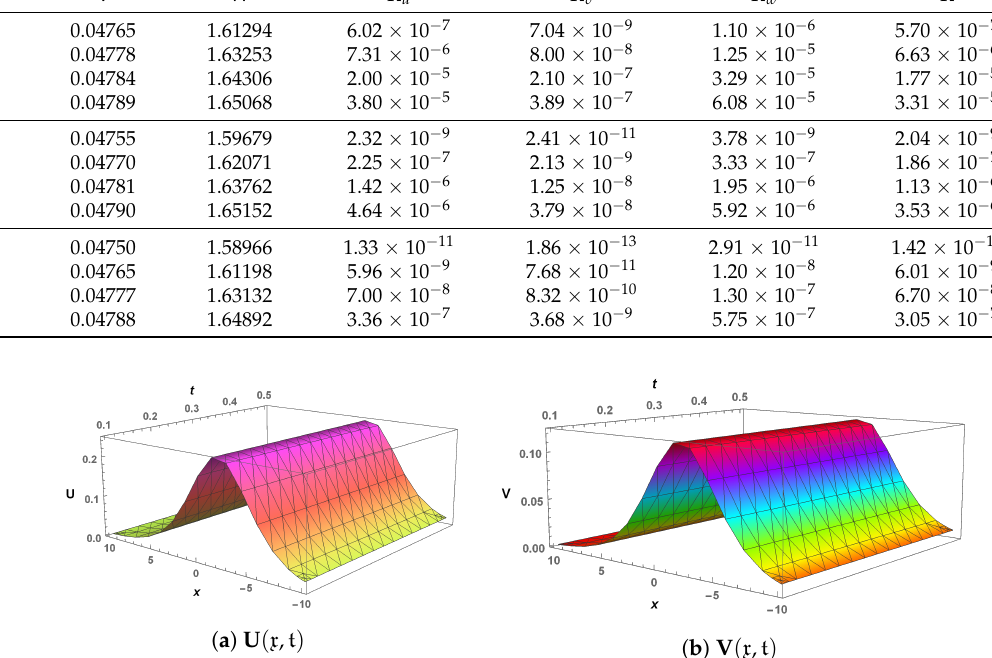
Figure 1. Three-dimensional (3D) plot of LHPM solution in Example 1, when β = 1, α = 1 and η = a =